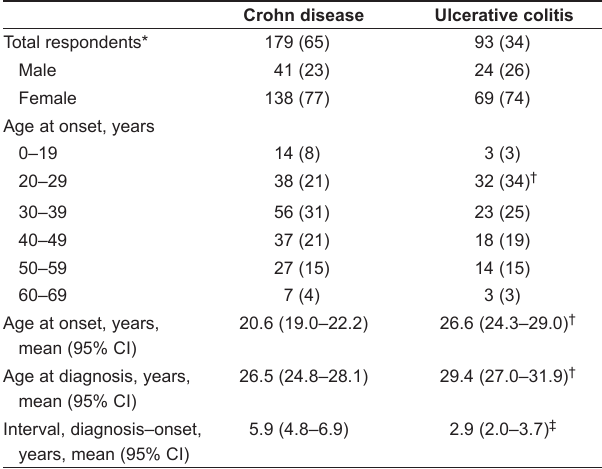
TABLE 1 Age and sex distribution of inflammatory bowel